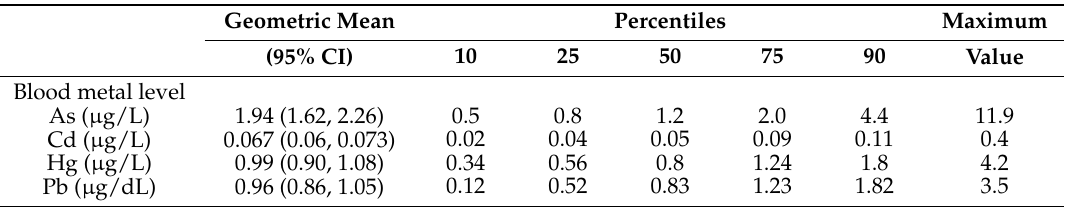
Table 2. Blood toxic metal levels in 210 infants.